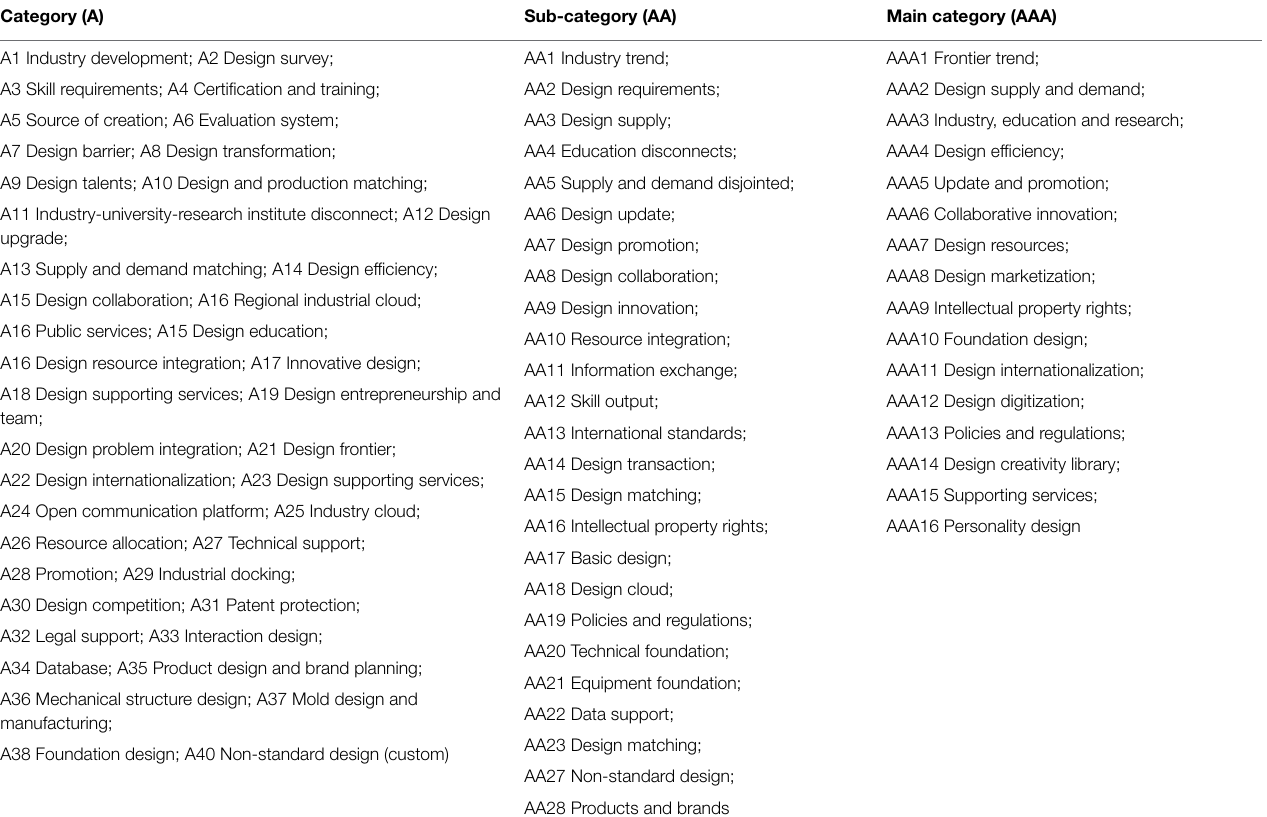
TABLE 2 | Categorization of spindle